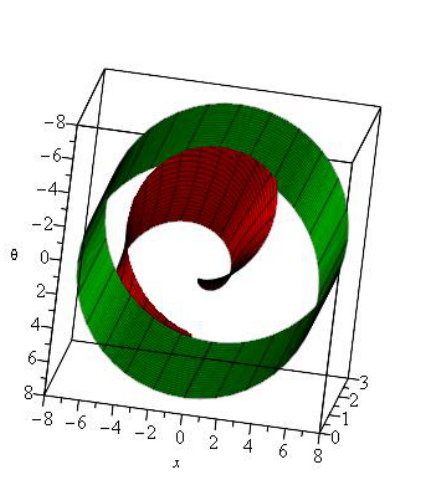
√ θ 2 − z 2 in red obtained using Maple